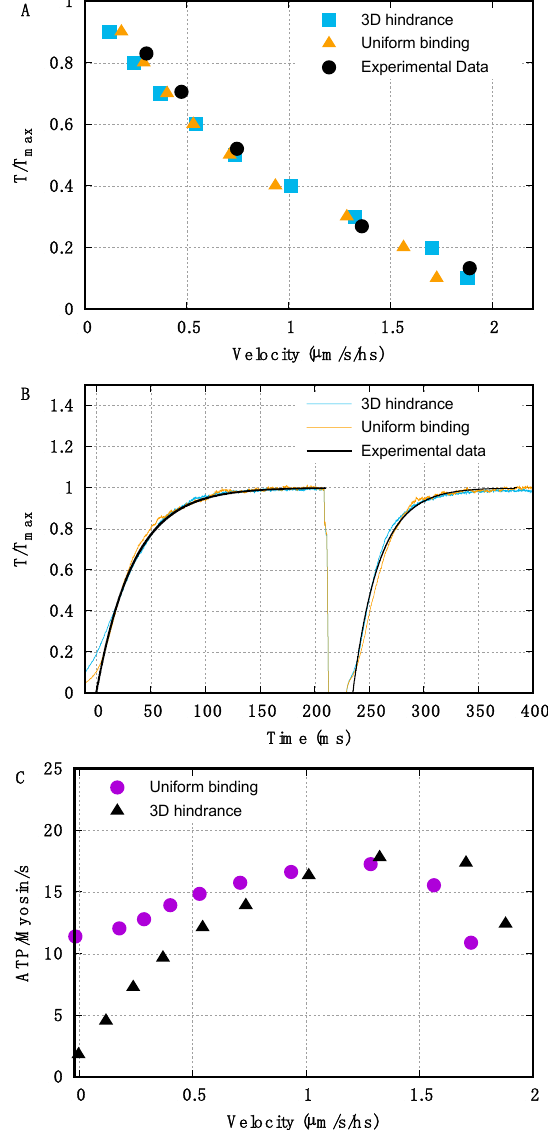
Figure 2. Comparison of the uniform binding region model vs. the limited target zones model, which generates geometrical hindrance. ( A ) The attachment rate k d is adjusted to fit the F ( v ) curve ON − a 0 (experimental data for Rana temporaria from [9], velocity in µ m per second per half sarcomere (hs)). Then, the detachment rate k a is adjusted to have 30% of motors attached in isometric contraction x − d ON (experimental data for Rana temporaria from [9]). ( B ) The rate of activation of the thick filament as (cid:16) (cid:17) F j a function of the force k d is adjusted to fit the kinetics of the force generation during OFF − d ON activation and force recovery after an unloaded shortening (experimental data for Rana temporaria from [12]). ( C ) Despite the mechanical behaviors being very similar for the two models, the uniformly distributed target zones (purple circles) induce a high r iso , while the limited target zones drastically ATP reduce it (black